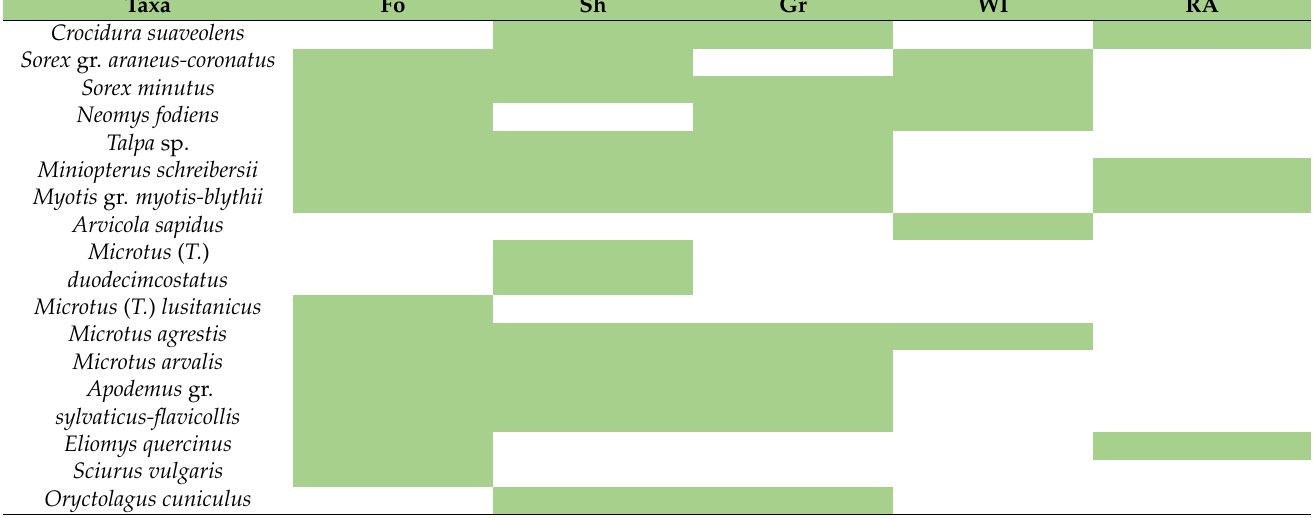
Table 2. Habitat affinities (in green) of small-mammal taxa identified at the early Chalcolithic levels of El Portal ó n de Cueva Mayor. Fo, forest; Sh, shrubland; Gr, grassland; WI, wetland (inland); RA, rocky areas including caves. Taxa Fo Sh Gr WI